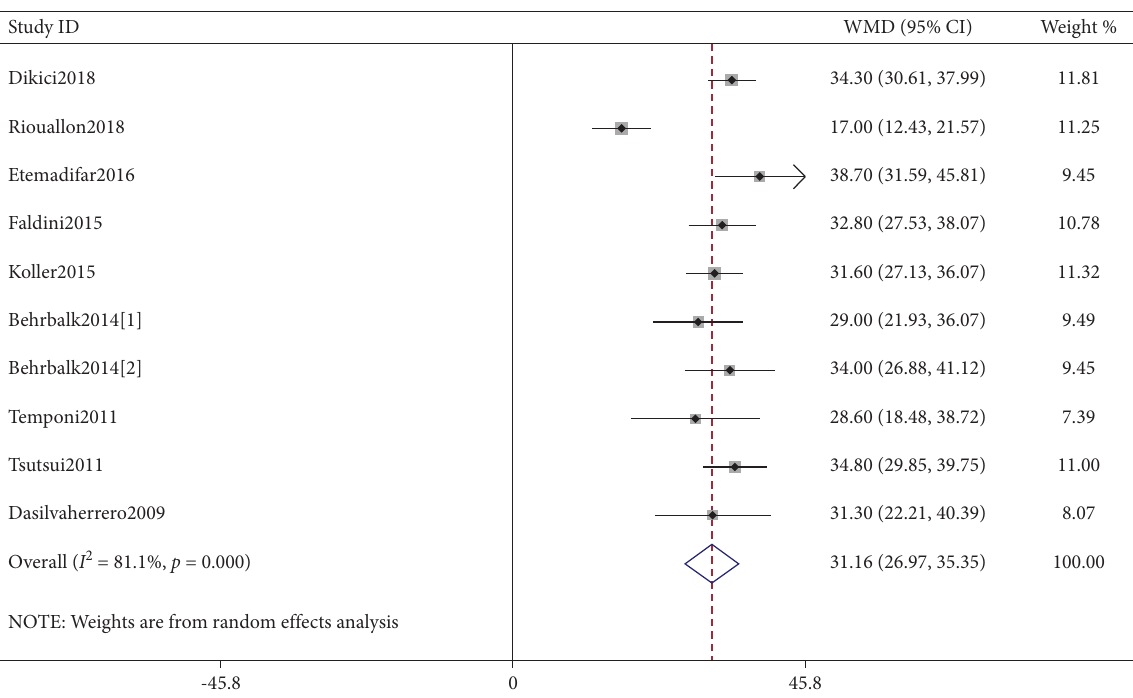
Figure 3: Forest plot of kyphosis correction by the posterior-only approach.